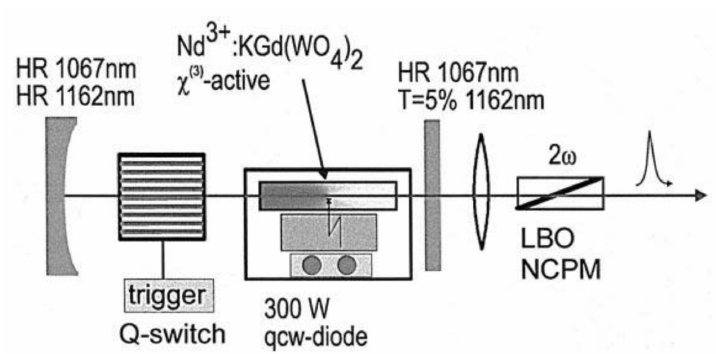
Figure 3. Schematic of the first actively Q-switched self-Raman laser